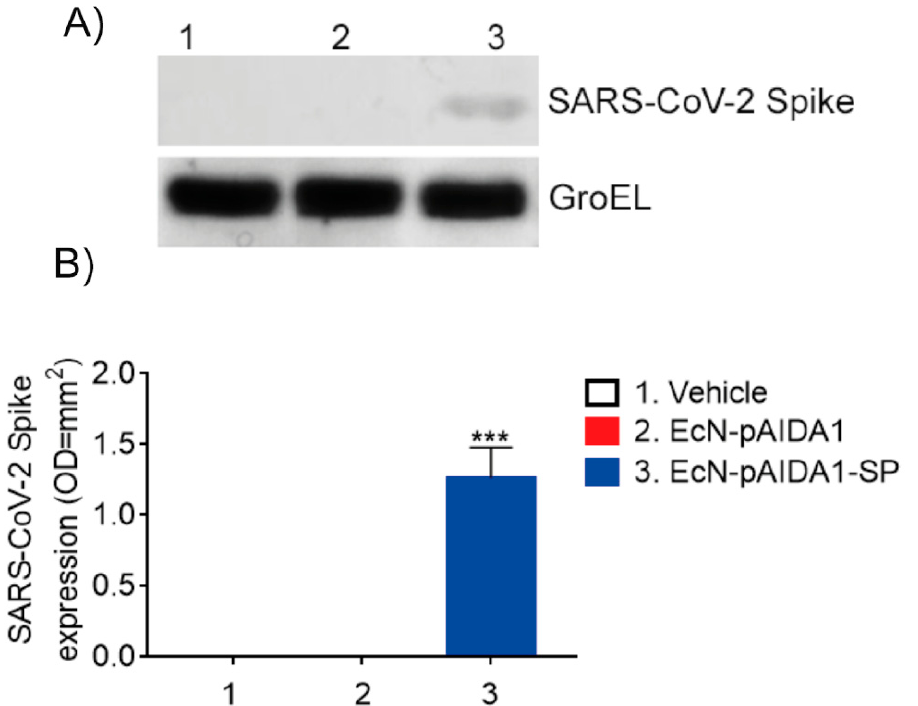
Figure 2. Expression of SARS-CoV-1 spike protein in fecal samples of the EcN-pAIDA1-SP, EcN- pAIDA1, and control mice. Western blot analysis for SARS-CoV-2 spike protein S1 quantification ( A , B ). Results are expressed in mean ± SD of n = 4 experiments performed in triplicate. (*** p < 0.001 vs. control group). (See Supplementary Figure S3 for uncropped blots).